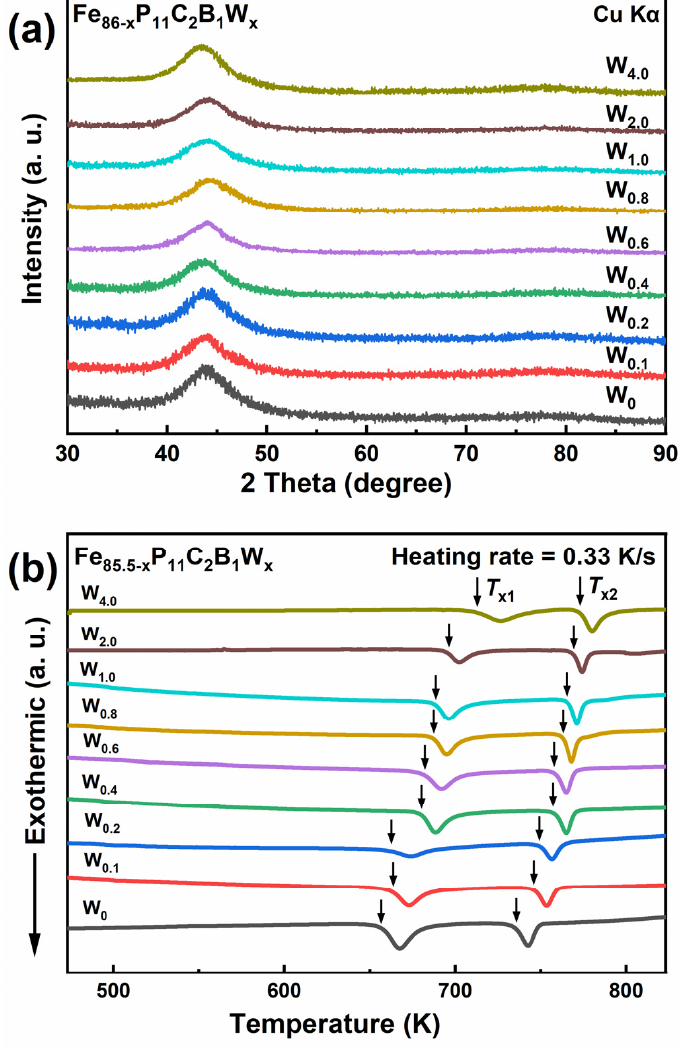
Figure 1. ( a ) XRD patterns and ( b ) DSC curves of the melt-spun Fe 86 − x P 11 C 2 B 1 W x ribbons. As shown in Figure 1b, the crystallization of the melt-spun Fe 86 − x P 11 C 2 B 1 W x (x = 0, 0.1, 0.2, 0.4, 0.6, 0.8, 1, 2, and 4) amorphous alloys was investigated by DSC with a heating rate